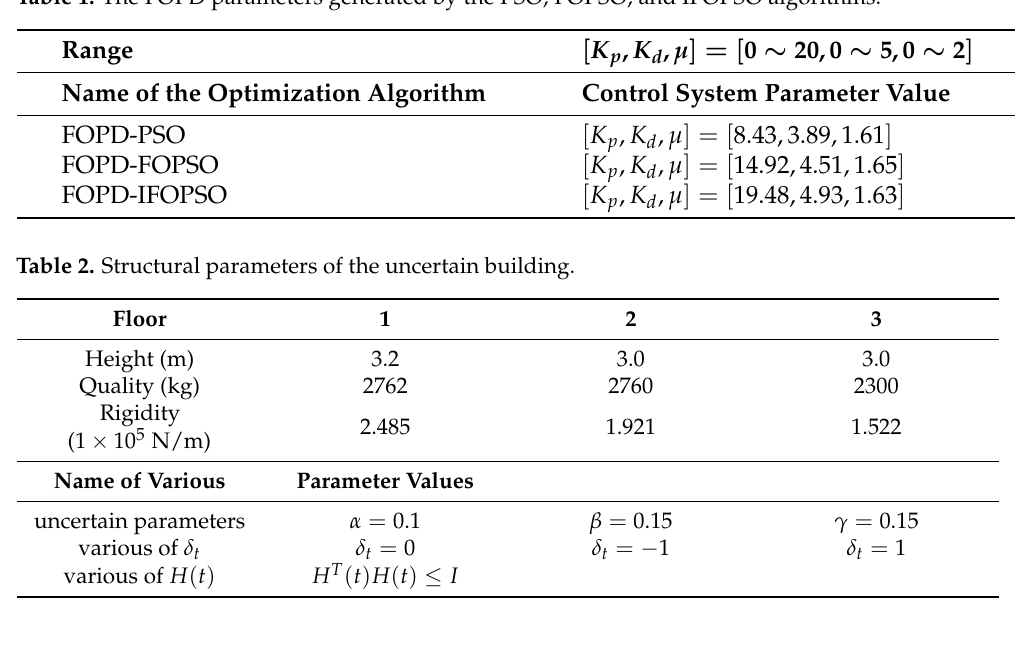
Figure 3. Flowchart of the IFOPSO algorithm for determining the parameters of the FOPD controller. Table 1. The FOPD parameters generated by the PSO, FOPSO, and IFOPSO algorithms.